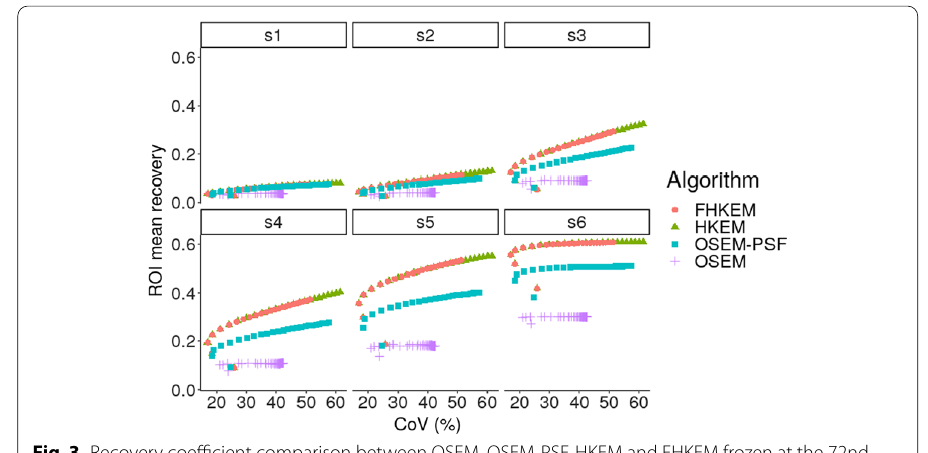
Fig. 3 Recovery coefficient comparison between OSEM, OSEM‑PSF, HKEM and FHKEM frozen at the 72nd sub‑iteration for each sphere